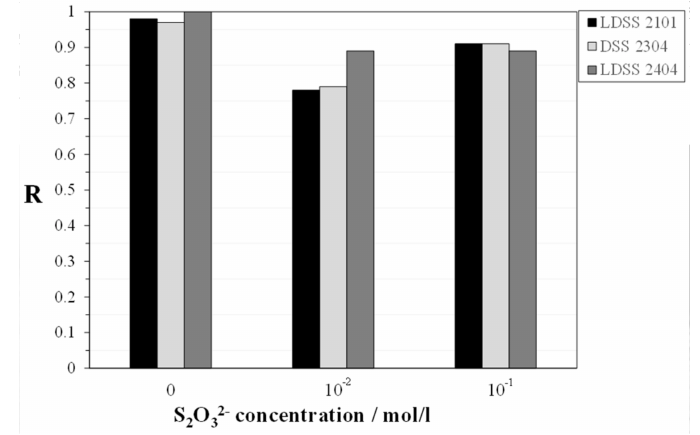
Figure 9. R index of the studied LDSS in 20% NaCl solution at 80 ◦ C, in the absence and in the presence of 10 − 2 and 10 − 1 M S 2 O 32 −